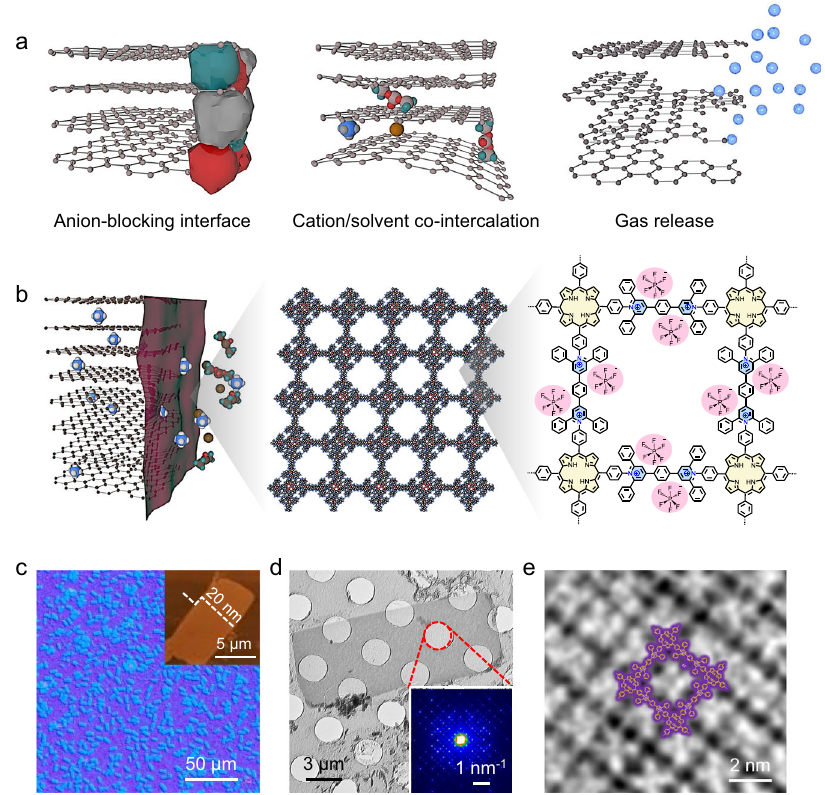
Fig. 1 | Anion-intercalation chemistries of graphite and morphological char- acterizationsofC2DP.a Schematicillustrationshowingchallengesassociatedwith the anion-intercalation chemistries of graphite. b Functions of C2DP as the elec- trode skin in promoting the anion-intercalation chemistries. c Optical microscopy image of C2DP. The inset shows an atomic force microscopy image of a single